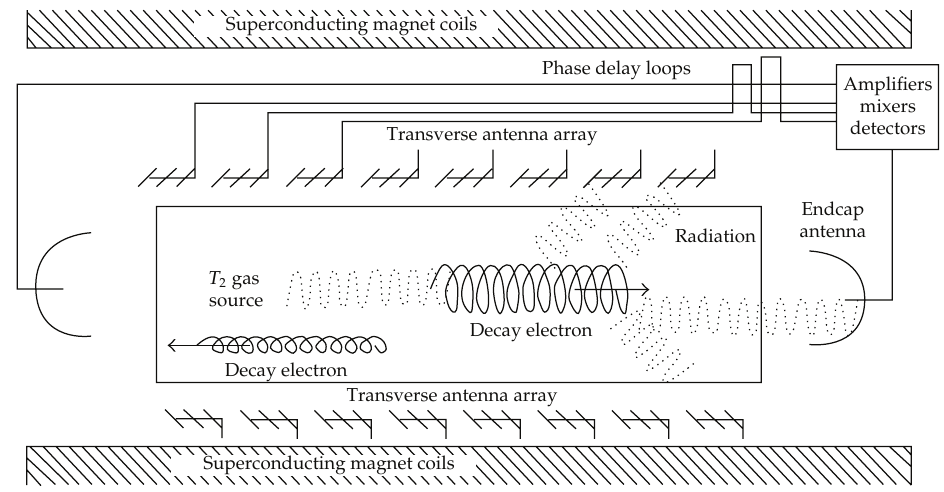
Figure 27: Schematic view of the experimental layout to measure coherent cyclotron radiation from tritium decay electrons (reprinted with permission from [170], Copyright (2009) by the American Physical